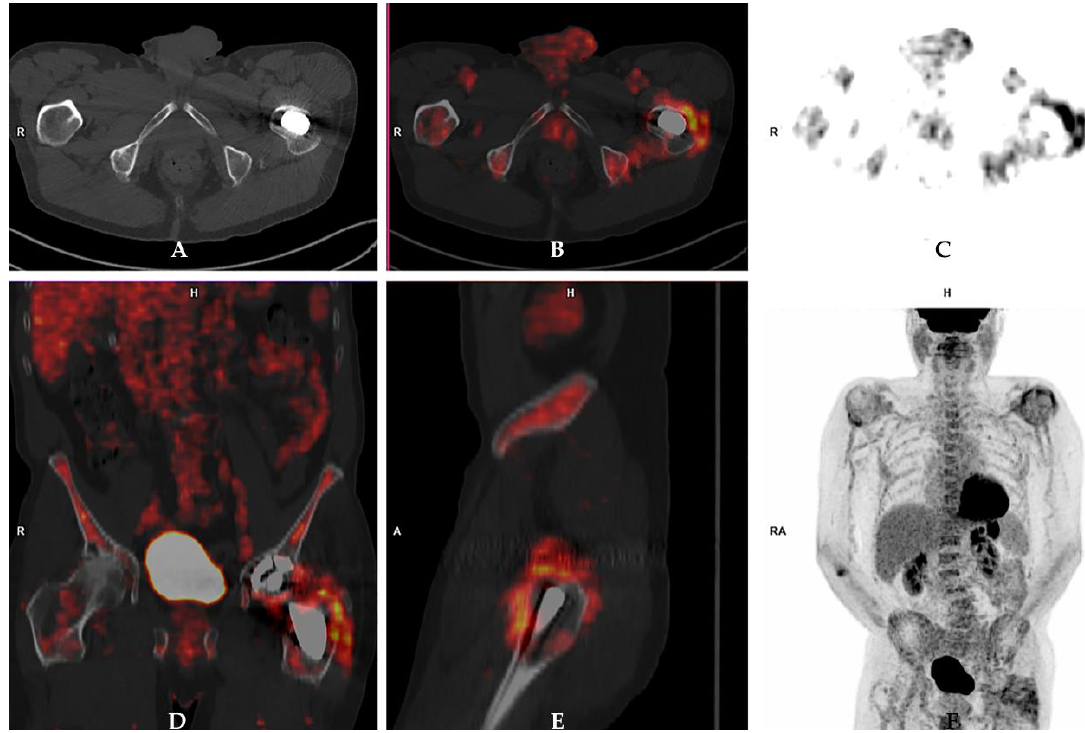
Figure 5. Prosthetic joint infection detected by 18Fluorine-fluorodeoxyglucose positron emission tomography/computed tomography ( [ 18 F]-FDG-PET/CT) in a 72-year-old male patient who underwent left hip arthroplasty four years before the PET/CT scan. [ 18 F]-FDG-PET/CT images ( A : axial view of CT scan; B : axail fused images; C: axial PET images; D : coronal [ 18 F]-FDG-PET/CT view; E : sagittal [ 18 F]-FDG-PET/CT view; F : maximum intensity projection [ 18 F]-FDG-PET images) showed increased radiopharmaceutical uptake in the periprosthetic bone and soft tissues at the level of the femoral component of the prosthesis. These findings were indicative of prosthetic joint infection, which was confirmed by further examinations including microbiological culture.